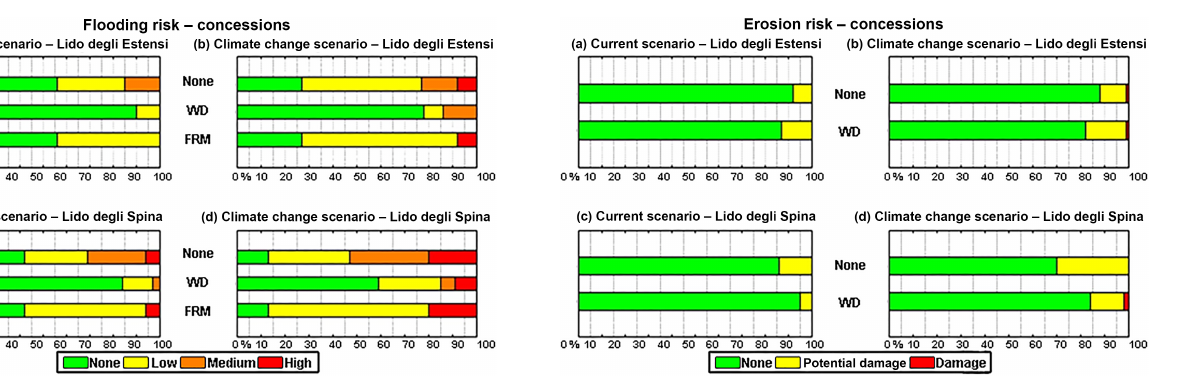
Figure 14. Distribution of concessions for every level of flooding risk. (a) Current scenario at Lido degli Estensi; (b) climate change scenario at Lido degli Estensi; (c) current scenario at Lido di Spina; (d) climate change scenario at Lido di Spina. Each bar in a panel represents a risk reduction configuration (“none”: no measure im- plemented; “WD”: winter dune; “FRM”: flood resilience measures). risk and with higher intensity. The presence of a CCS exac- erbates expected impacts.